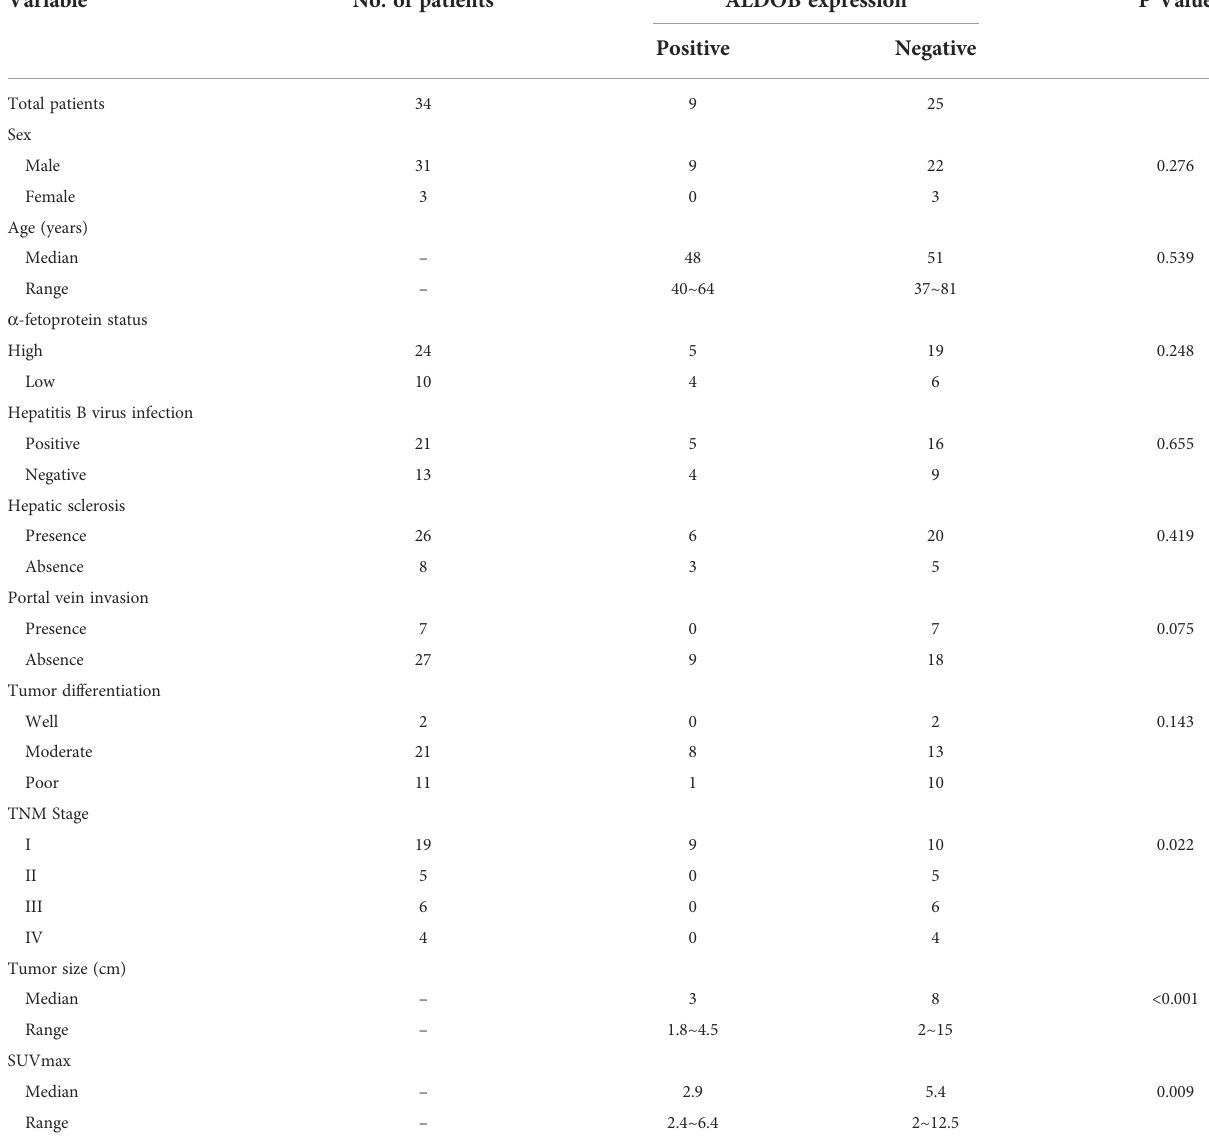
TABLE 1 Relationship between ALDOB expression of tumor tissues and clinical-pathologic characteristics in 34 patients with HCC.